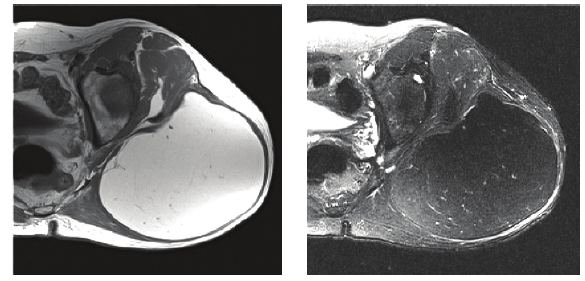
Figure 2: Axial T1 and T2 MRIs of a patient with a large fatty tumor in the buttock. Despite the large size and intratumoral strand- ing/nodularity, final pathological review confirmed a diagnosis of